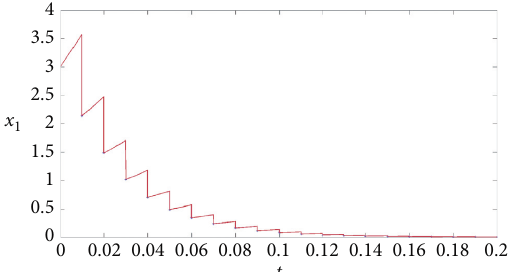
Figure 7: The trajectory of the state x coefficients a � 35, b � ( 8/3 ) , c � 25, t k � 0 . 01 k ( k � 1 , 2 , . .. , ) , d � 0 ( i, j � 1 , 2 , 3 , i ≠ j ) , and d ij condition x ( 0 ) � ( 3 , 4 , 5 ) T .